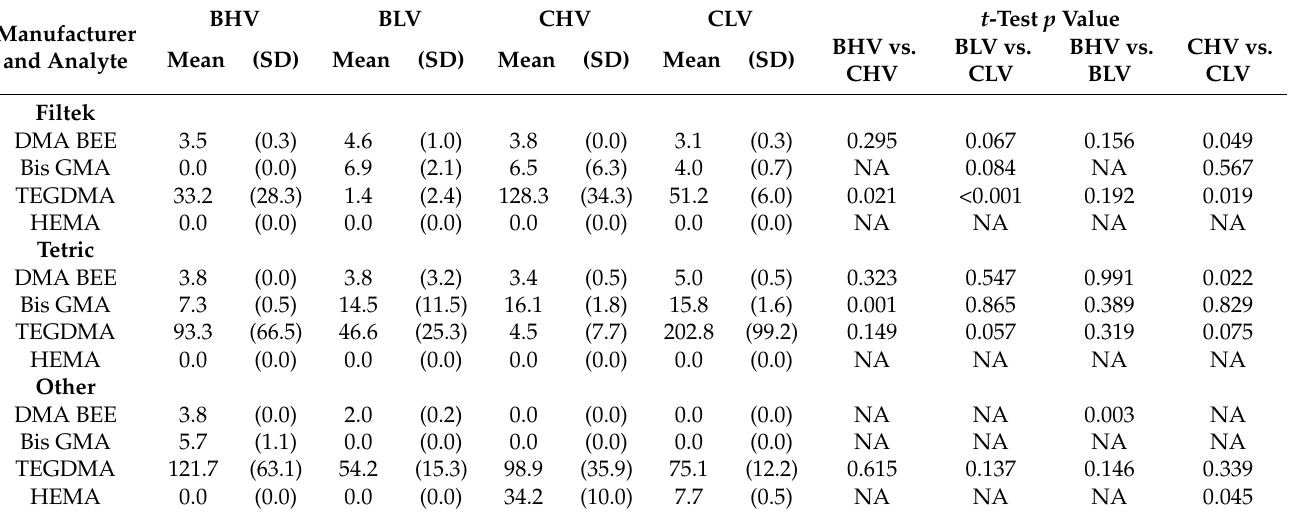
Table 4. Concentration of different compounds leached from different types of dental material preparations from the same manufacturer after 28